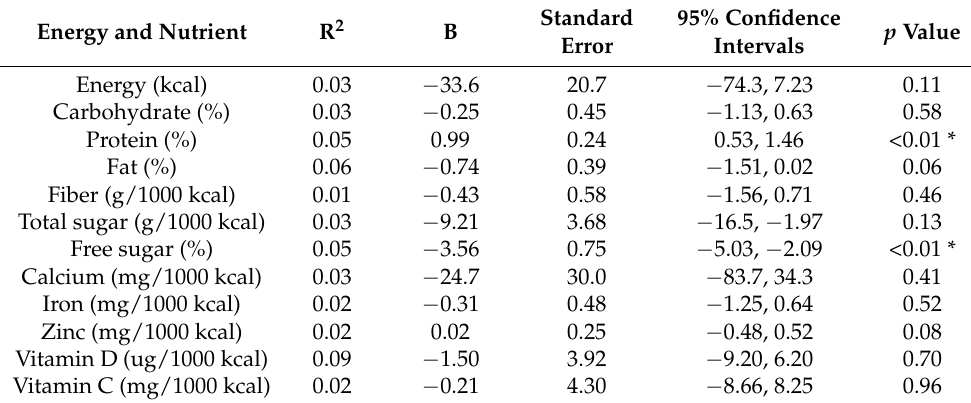
Table 4. Multiple linear regression analyses of maternal use of a healthy food environment on energy and nutrient intakes of children a